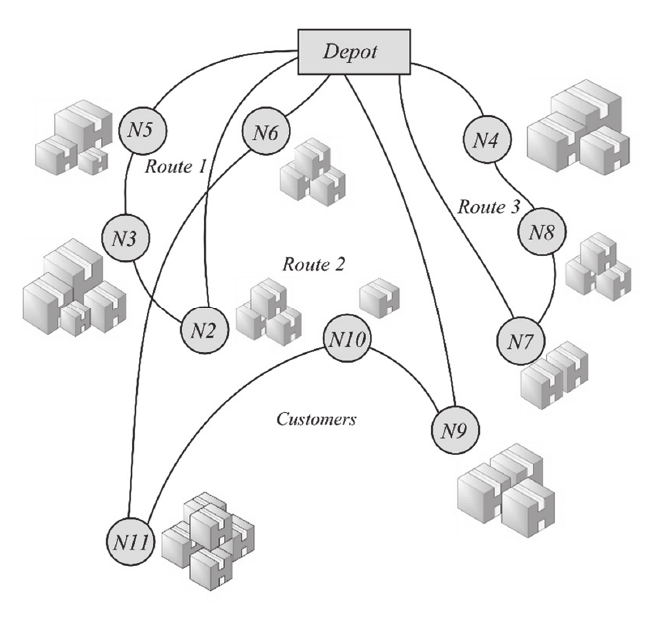
Fig. 2. Joint BPP and CVRP